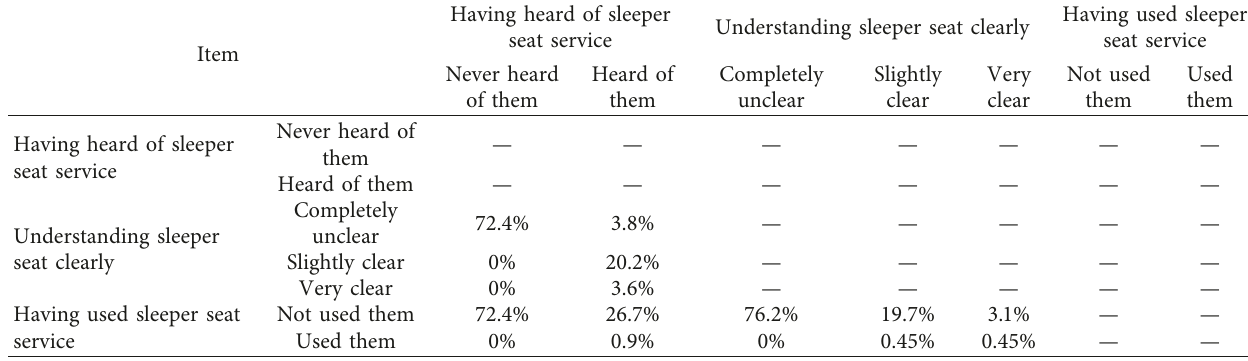
Table 5: Respondents’ awareness of sleeper seat (2).